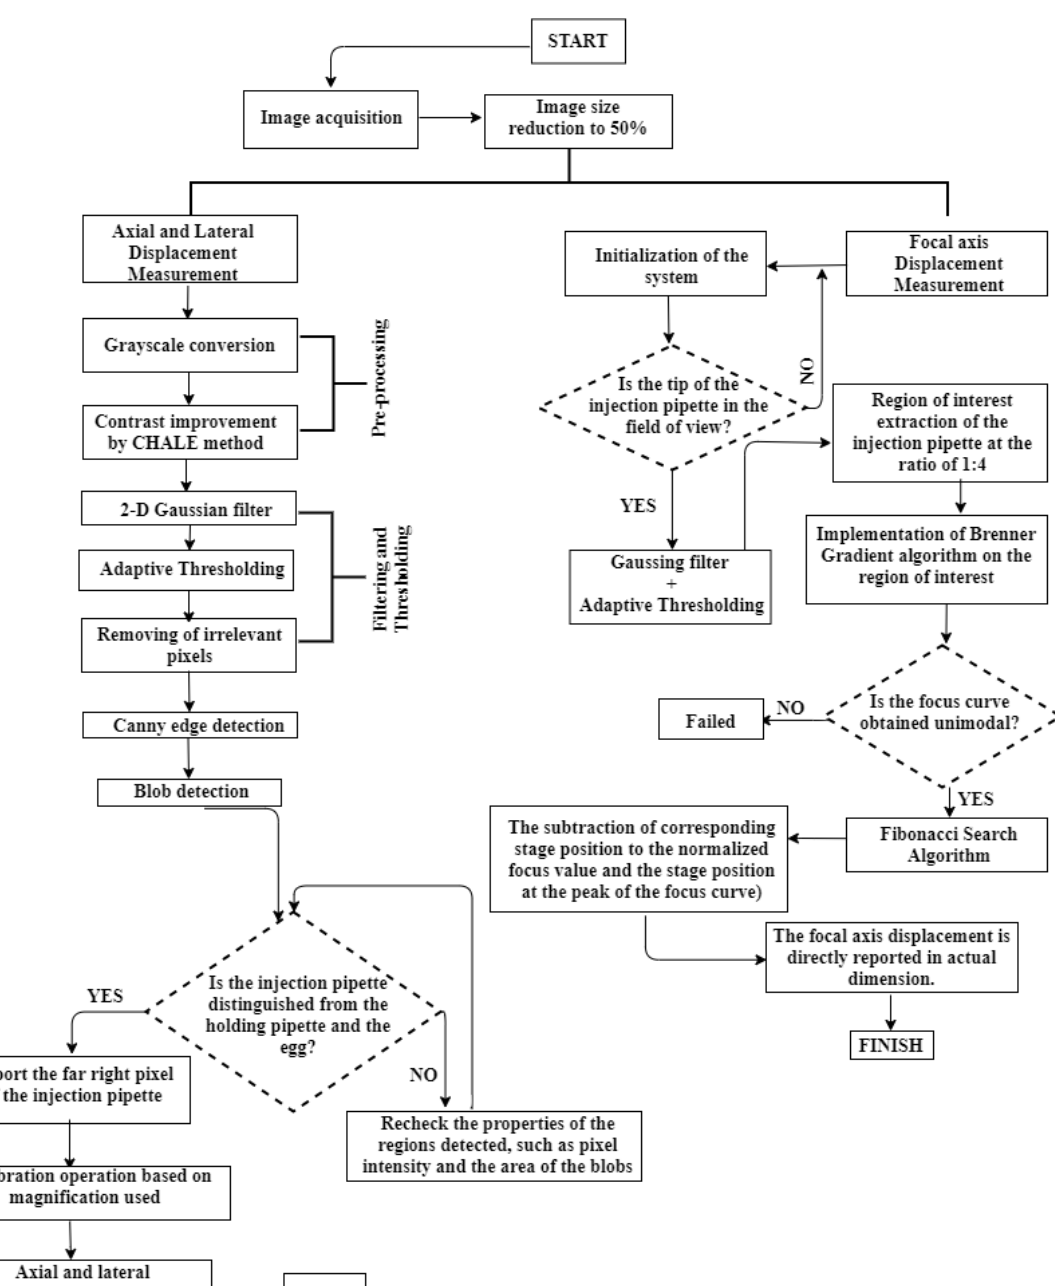
Figure 7. Block diagram of the vibration displacement sensing procedure by the developed vision algorithms in 3